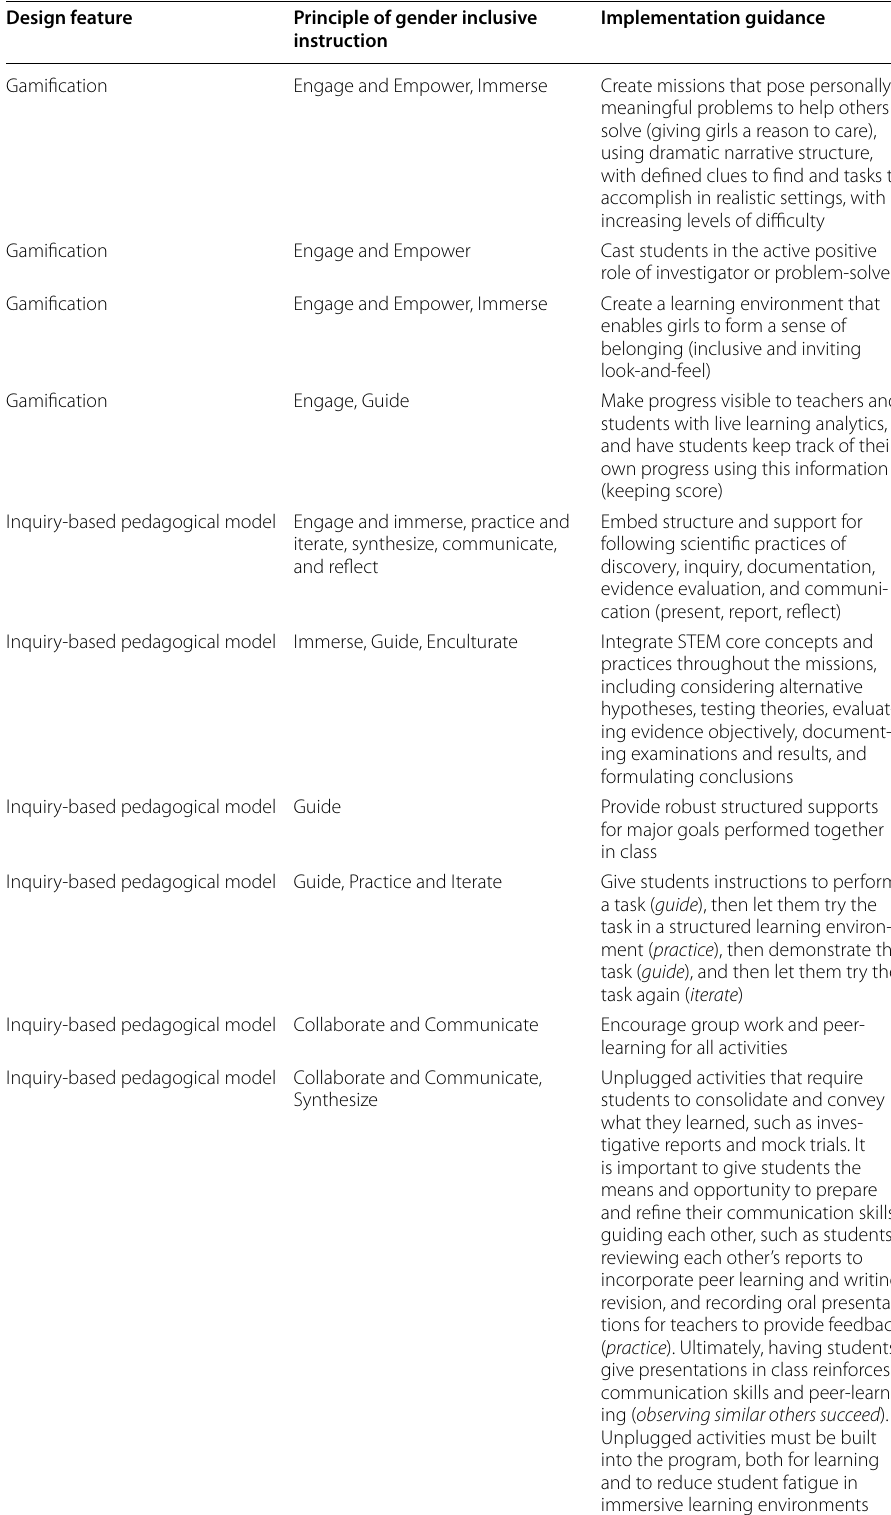
Table 1 Implementation strategies for gender inclusive STEM